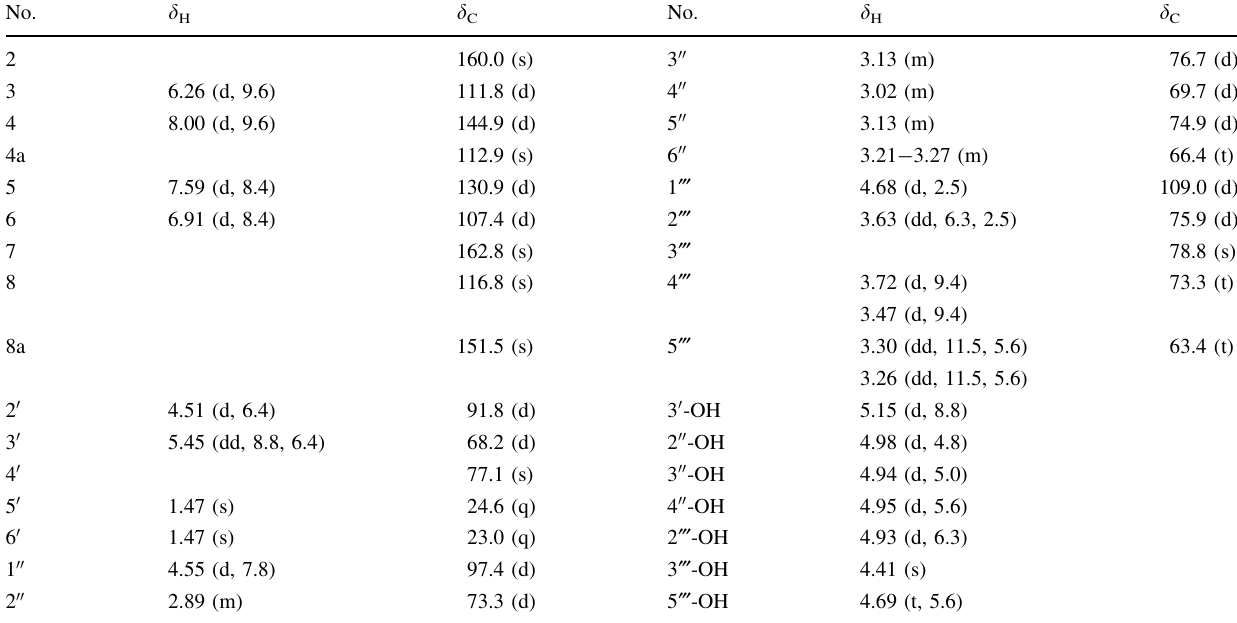
Table 1 NMR spectroscopic data for 6 00 - O - b - D -apiofuranosylapterin ( 1 ) in DMSO- d 6 ( d H 2.49, d C 39.5 ppm)